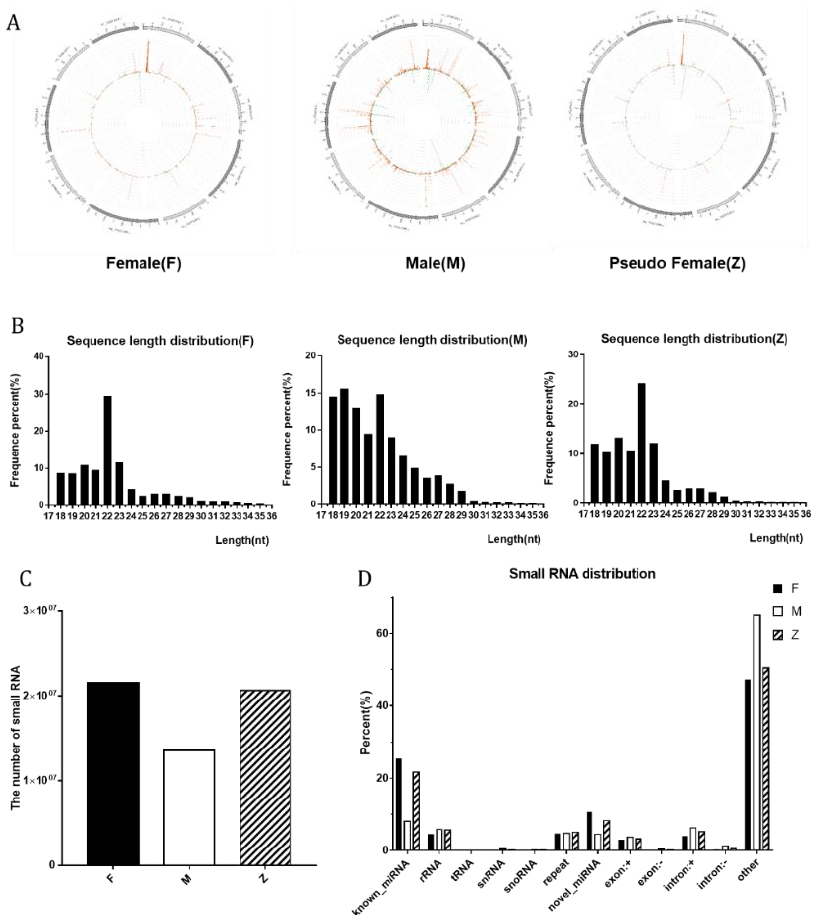
Figure 2. The distribution and number of small RNA among males, females, and pseudo-females: ( A ) Distribution of small RNAs of female, male, and pseudo-female individuals on the genome. ( B ) The sequence length distribution of small RNAs of female, male, and pseudo-female individuals. ( C ) The number of small RNAs of female, male, and pseudo-female individuals. ( D ) The small RNAs distribution of female, male, and pseudo-female individuals. Table 2. Data output statistics of three samples (F, M, Z).